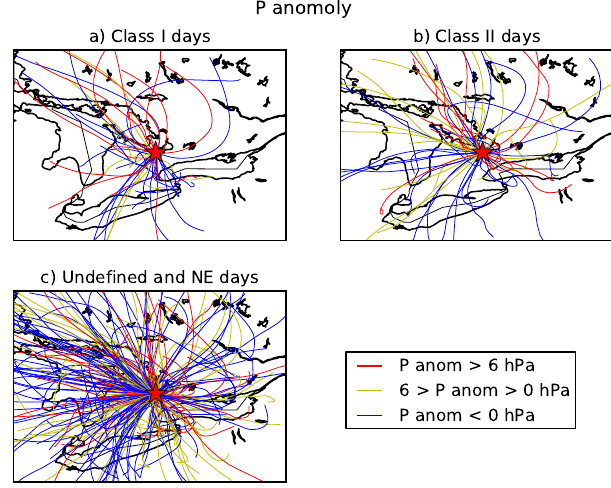
Figure 8. The 24h back trajectories arriving during the new- particle-formation event during each class I, II and undefined + non- event day (one back trajectory per event). Trajectories are color- coded by the surface-pressure anomaly (from the 28-day running mean) measured during the